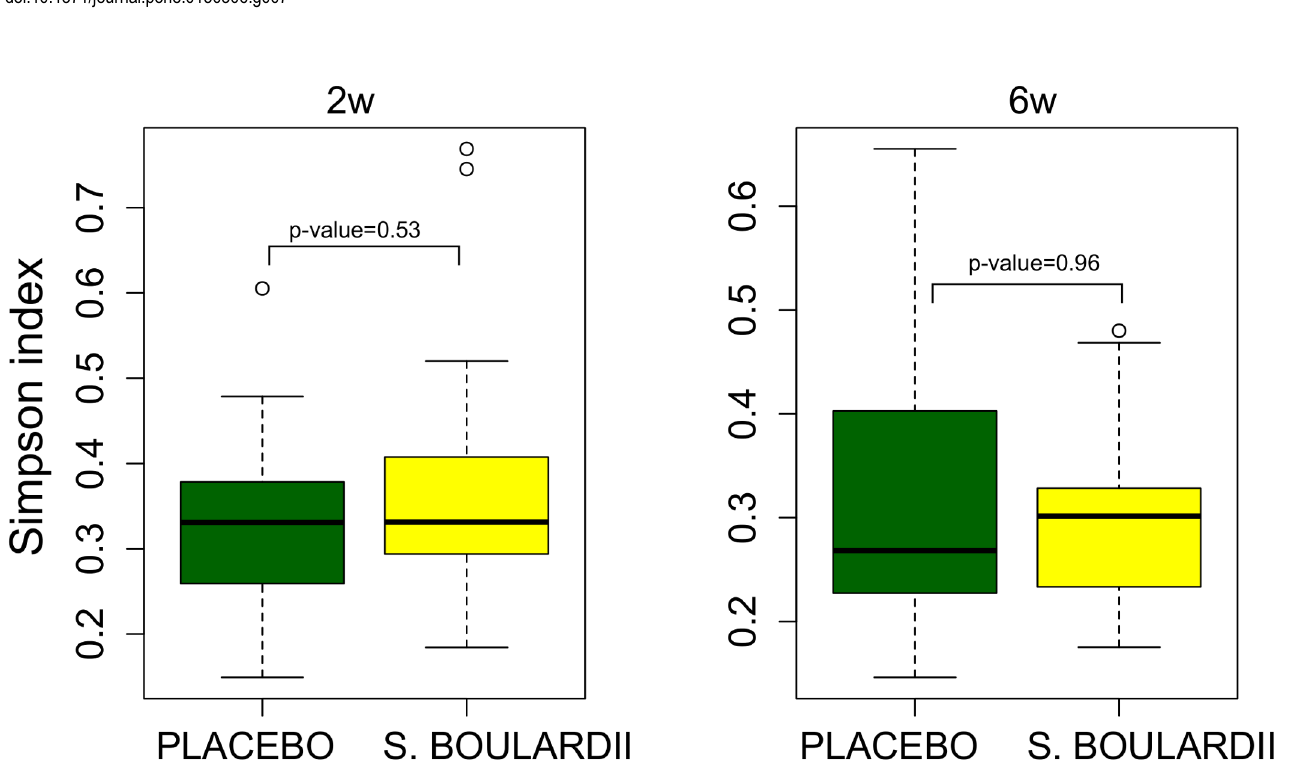
Fig 8. Boxplot of community α diversity, as expressed by the Simpson index, categorized according to the administration of the probiotic Saccharomyces boulardii ( S . Boulardii ) or placebo at 2 (2w) and 6 (6w) weeks following intervention. P-values in Mann-Whitney U-test are shown for respective times.